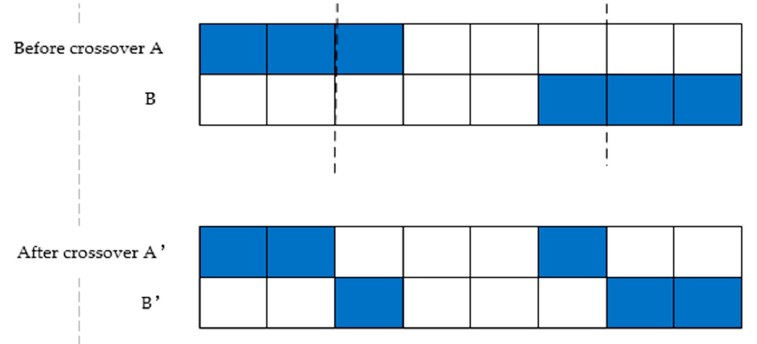
Figure 2. Two-point crossover operation. ( A ) and ( B ) are two randomly selected individuals, and A’ and B’ are the resultant individuals after the crossover operation.